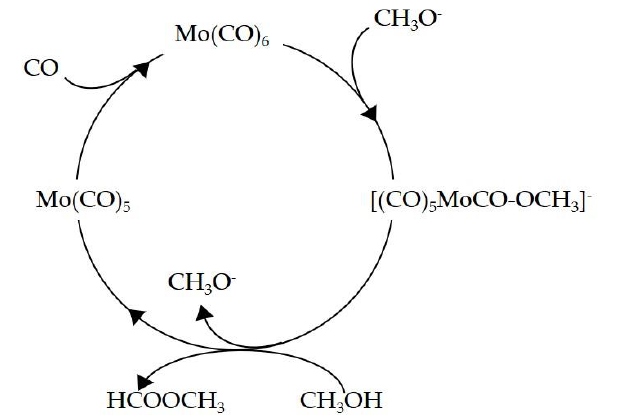
Figure 2. Catalysis mechanism of methanol carbonylation with methoxide and Mo(CO) 6 for pro- duction of MF [4].